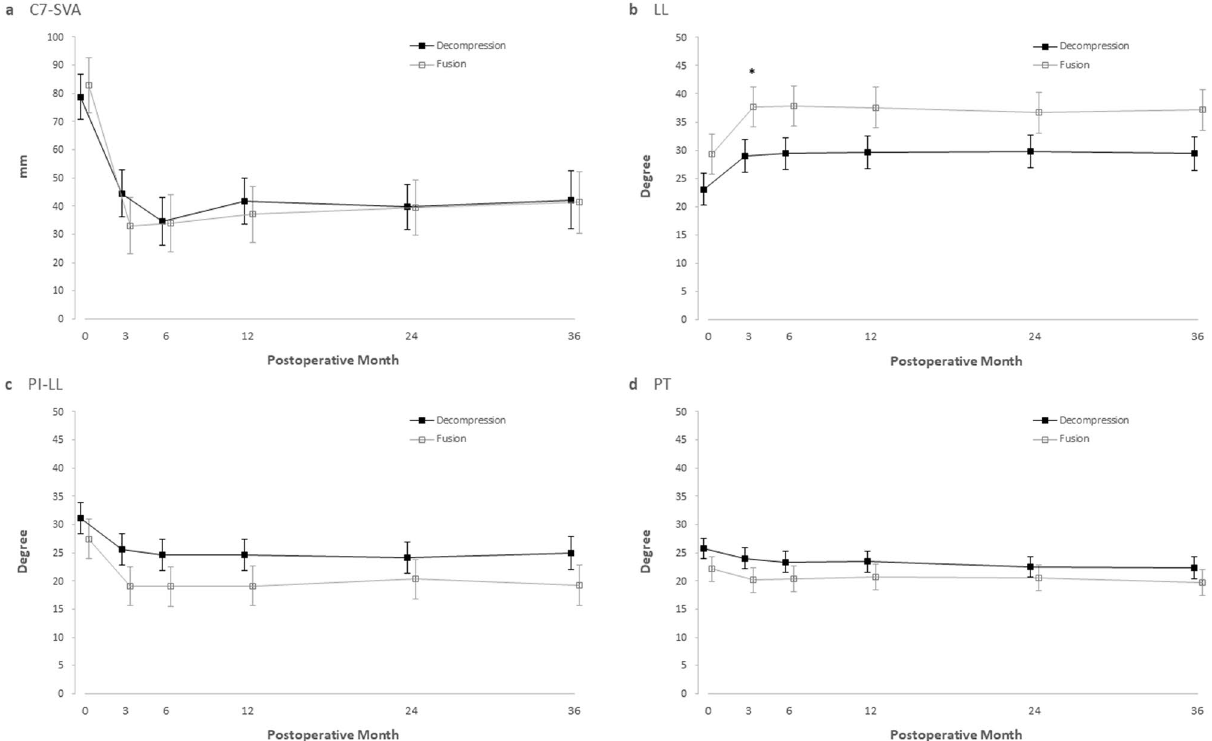
Figure 3. Comparison of radiological parameters. Shown are adjusted value of radiological parameters before and after surgery, among D-group and F-group. I bars represent standard errors. ( a ), C7-Sagittal vertical axis (C7-SVA); ( b ), lumbar lordosis (LL); ( c ), difference between pelvic incidence and lumbar lordosis (PI-LL); ( d ), pelvic tilt (PT). An asterisk (*) means statistical significance ( p <